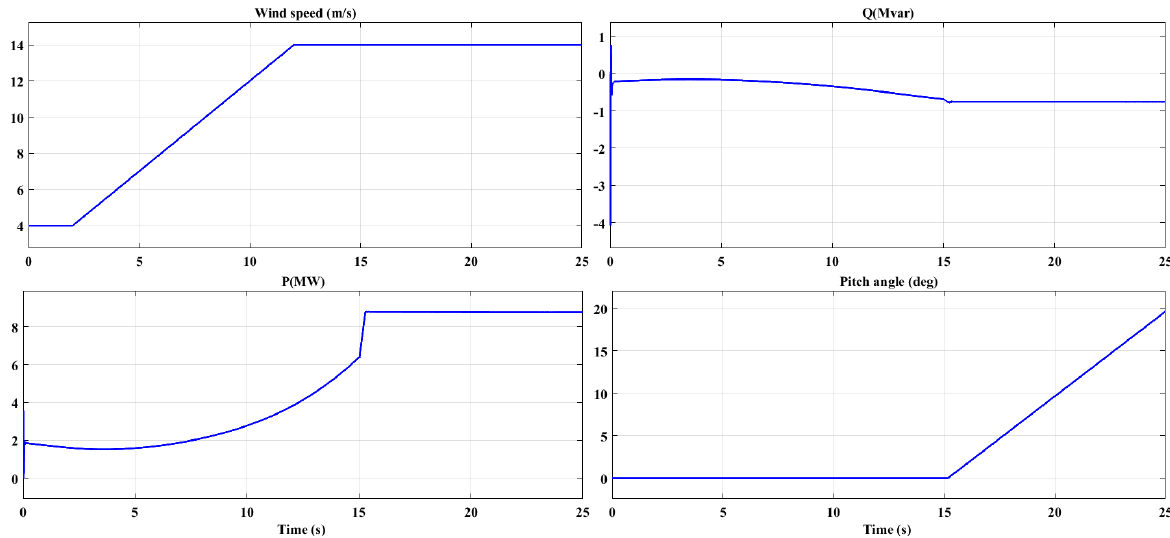
Figure 11. DFIG Wind turbine response at variable wind speeds.